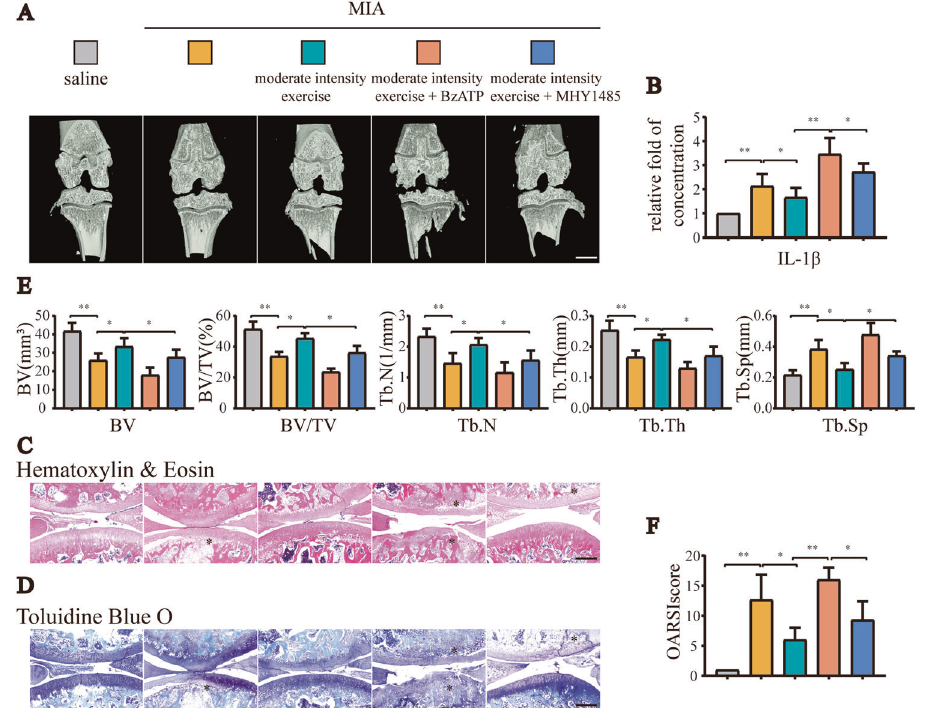
Fig. 2 Increased expression of P2X7 or inhibition of autophagy offset the anti-in fl ammatory effects of moderate-intensity exercise. We set the following fi ve groups: saline, MIA, MIA + moderate-intensity exercise, MIA + moderate-intensity exercise + BzATP, MIA + moderate- intensity exercise + MHY1485. A total of 50 rats were randomly assigned, with 10 rats in each group. A Micro-CT scanning of knee joints in each group was used to obtain imaging data for the tibial plateau and subchondral bone (scale bar: 1 mm). B ELISA was used to determine IL- 1 β levels in the articular cavity lavage fl uid of rats in each group. C H&E staining and D TB staining were used to analyze the degree of cartilage loss and the development of in fl ammation. E Knee joint bone-related parameters, including BV, BV/TV, Tb.N, Tb.Th, and Tb.Sp, as evaluated by micro-CT. F OARSI scores were used to determine the development stage of OA in the knee joint tissues of rats in each group. The * in the HE and TB staining images represents the cartilage damage site. Data are presented as means ± standard deviations of at least three independent experiments. * p < 0.05, ** p <